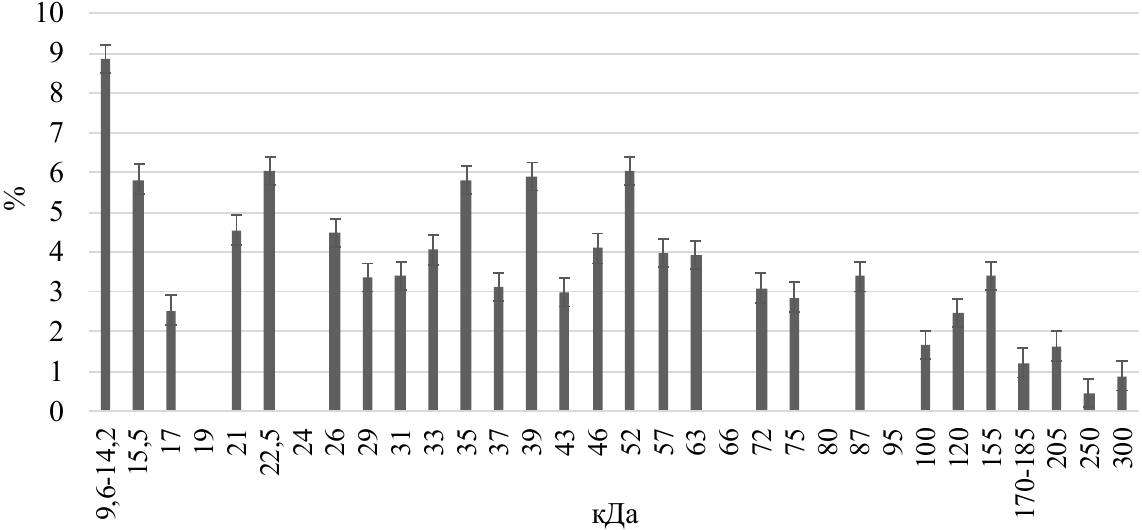
Fig. 2. Structural proteins of the apical membrane of the hollow enterocytes of three-month-old cattle fetus (M ± m; %; n =